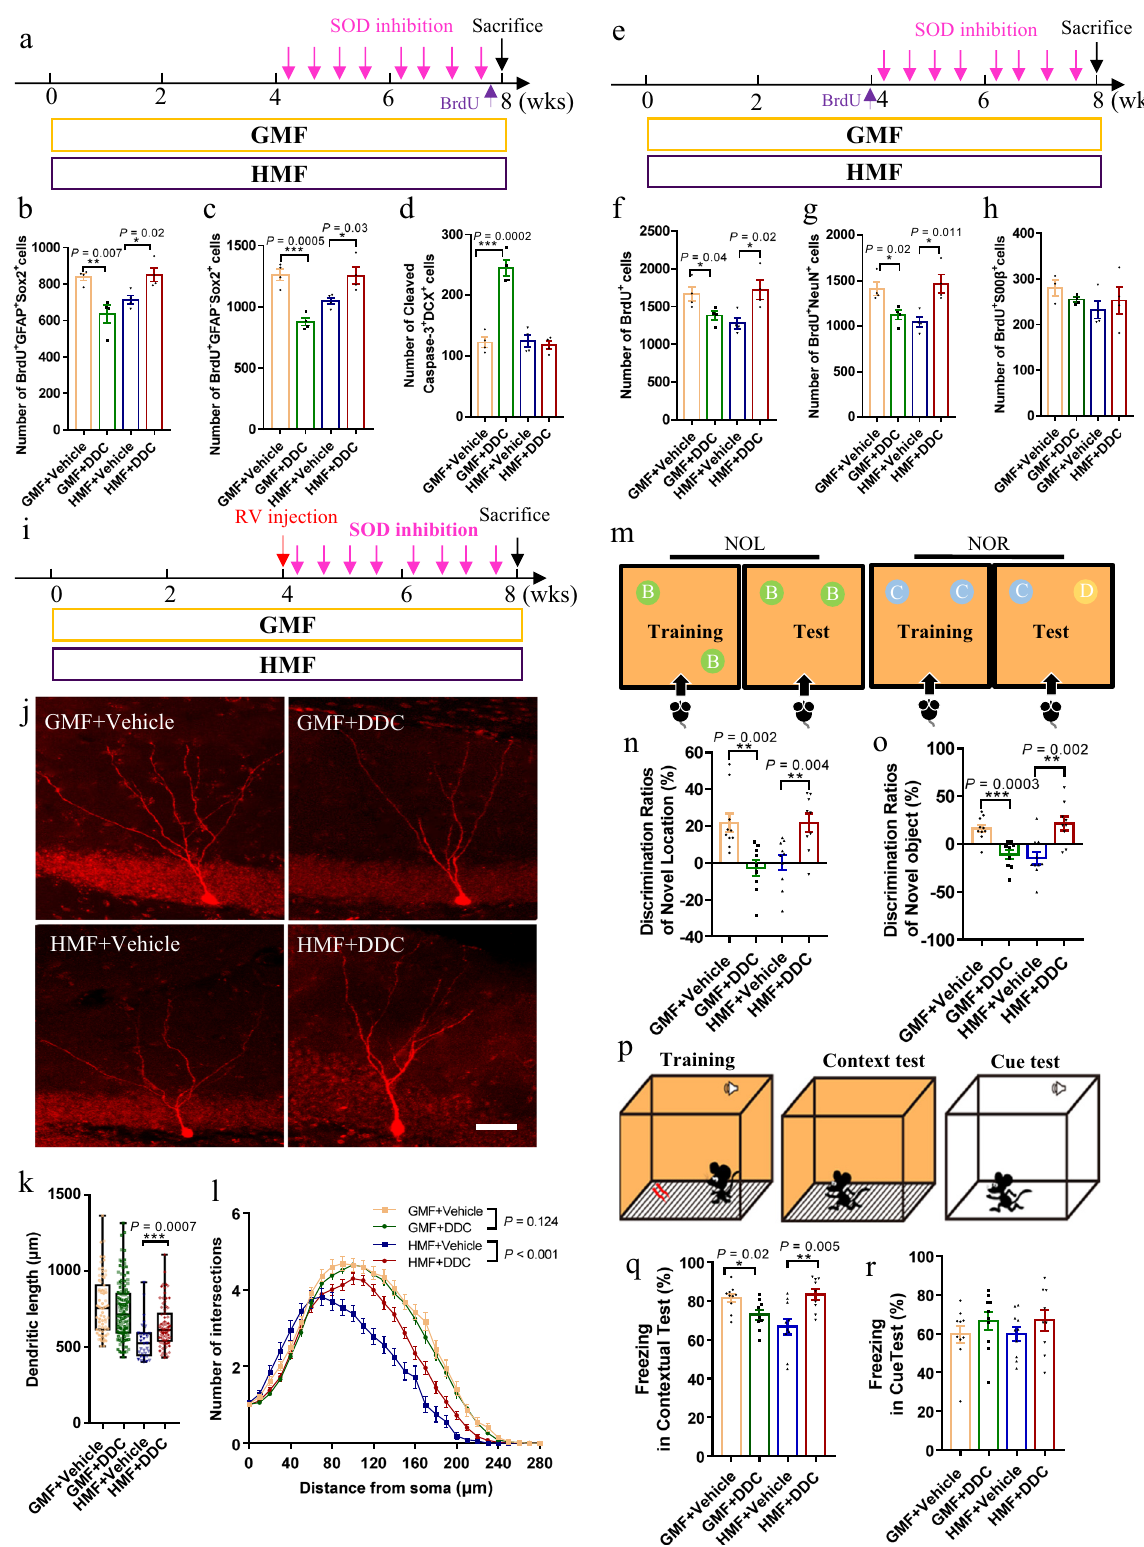
Sox2 + type 1 aNSCs (Fig. 7b) and BrdU + GFAP – Sox2 + type 2 aNSCs (Fig. 7c) in HMF-exposed mice 2 h post BrdU injection, as well as the numbers of BrdU + cells (Fig. 7f) and BrdU + NeuN + neurons (Fig. 7g) in HMF-exposed mice 4-weeks post BrdU injection. In addition, we found that return to GMF signi fi